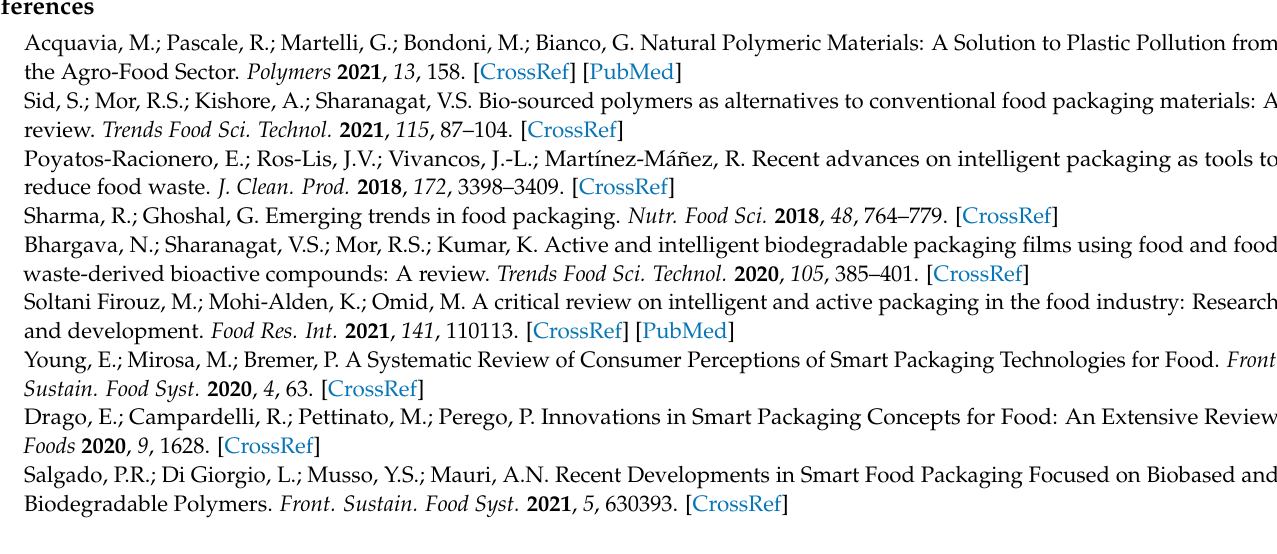
dye; Figure S2: 1 H-NMR spectrum of the bio-inspired dye; Figure S3: 13 C-NMR spectrum of the bio-inspired dye; Figure S4: DEPT 135 spectrum of the synthetized dye; Figure S5: HMBC spectrum of the synthesized dye; Figure S6: UV-VIS spectrum of the dye; Figure S7: Thermogram of the dye; Figure S8: UV-VIS spectra of dye solutions (7 · 10 –5 M methanol: water 1:14) at pH values ranging from 2 to 12 over time; Figure S9: FT-IR spectra of chitosan–starch–dye (green), chitosan–starch (blue), and dye (red); Figure S10: FT-IR spectra of chitosan–PVA–dye (green), chitosan–PVA (blue), and dye (red); Figure S11: UV-VIS spectra of the chitosan-starch-dye films after 1 h in buffer solutions a) and of the buffer solutions b); Figure S12: UV-VIS spectra of the chitosan–PVA–dye film after 1 h in buffer solutions a) and those of the buffer solutions b); Figure S13: UV-VIS spectra of the chitosan–cellulose– dye film after 1 h in buffer solutions; Table S1: Weight losses of the chitosan–cellulose–dye film, chitosan–cellulose film, and the dye; Table S2: Weight losses of the chitosan–starch–dye film, chitosan– starch film, and the dye; Table S3: Weight losses of the chitosan–PVA–dye film, chitosan–PVA film, and the